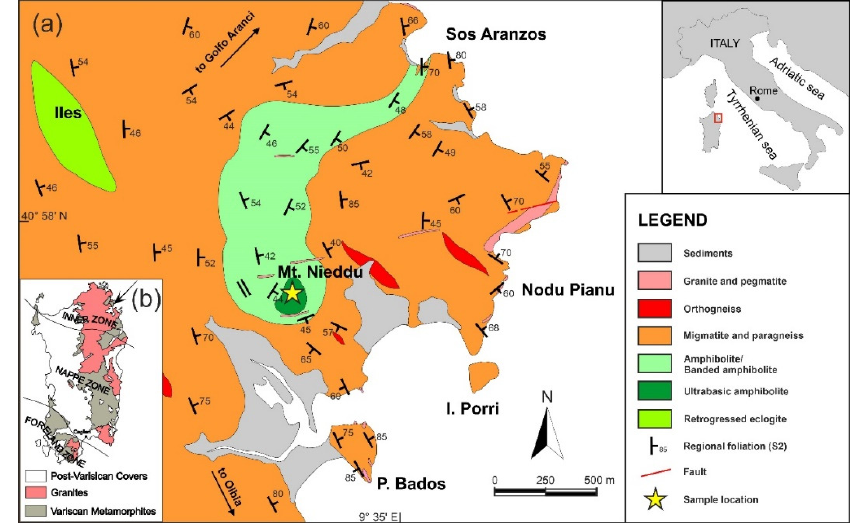
Figure 1. ( a ) Geological sketch map of the Mt. Nieddu area, ( b ) Tectonic sketch map of the Sardinian Variscan chain.